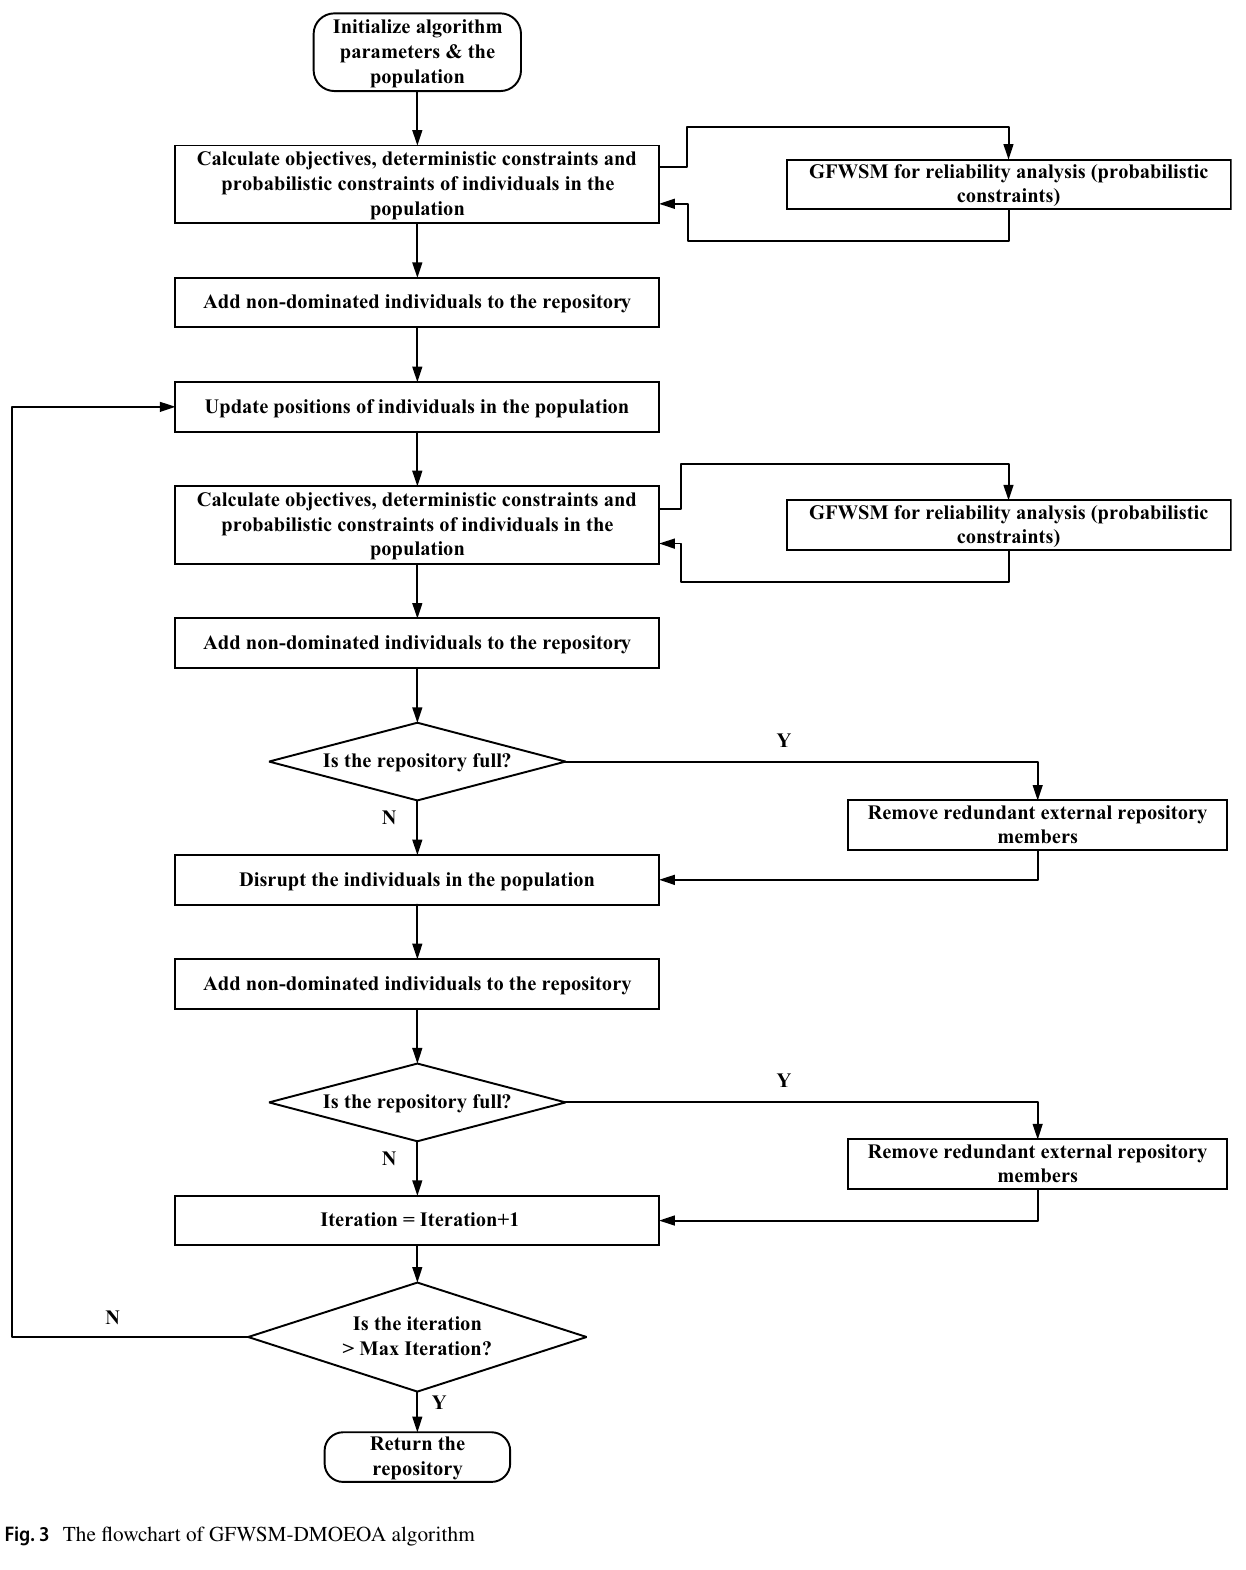
Fig. 3 The flowchart of GFWSM-DMOEOA